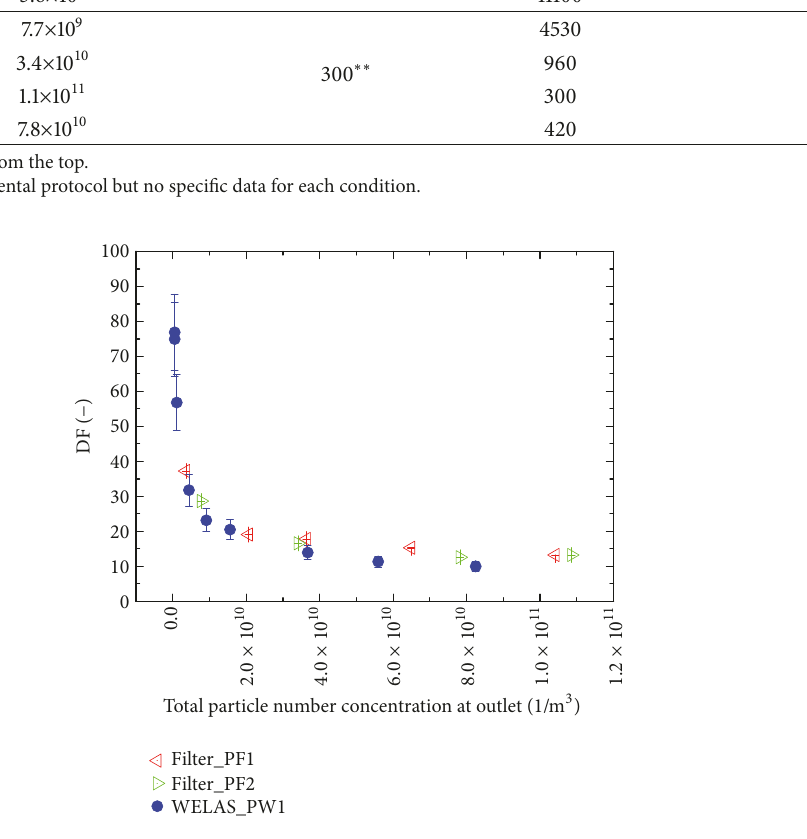
Figure 4: Comparison of DFs derived from filter and